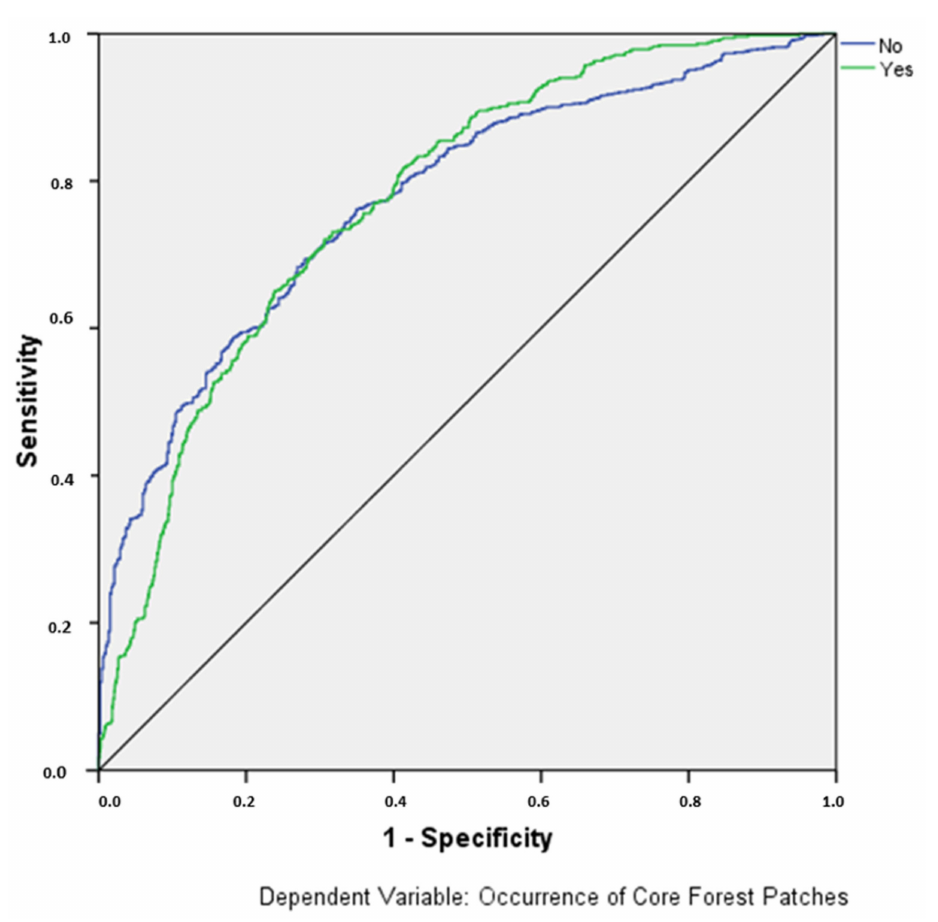
Figure 3. Area under the curve showing the occurrence of core forest patches as a classified binary ariable. Table 3. Omnibus Tests of Model